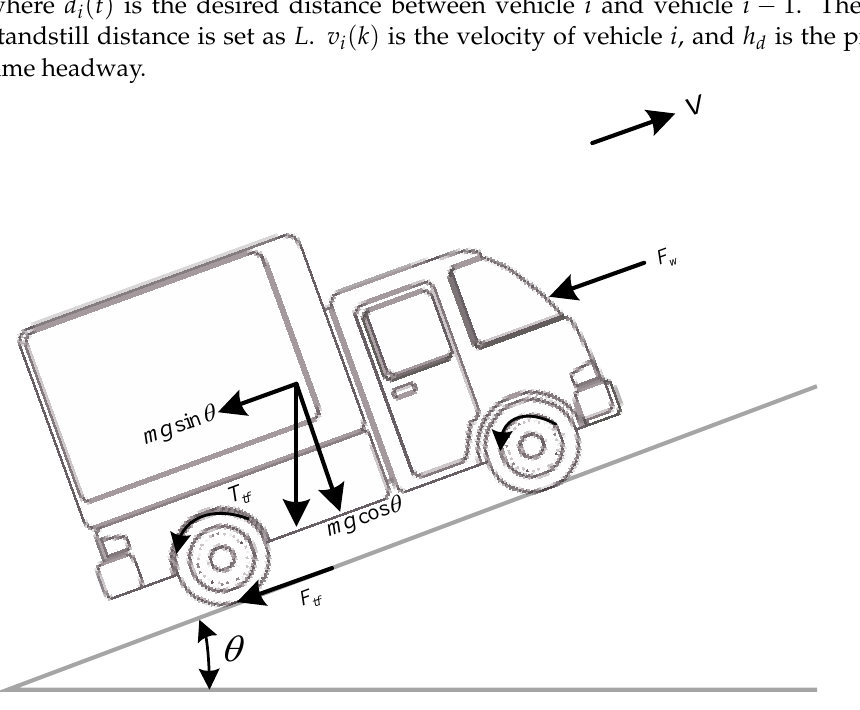
Figure 3. Vehicl